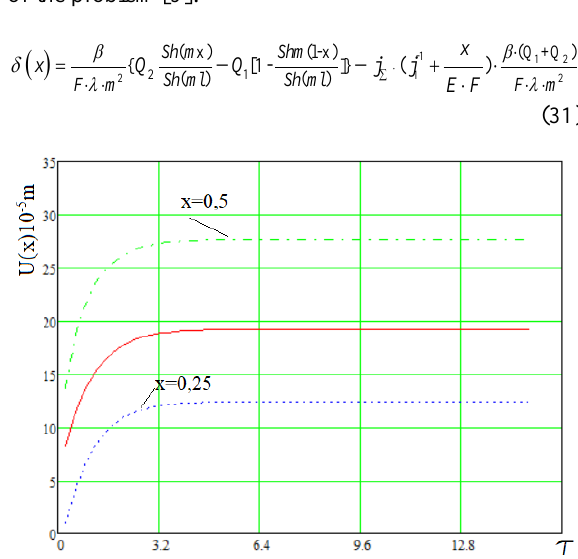
Fig. 4. The calculated values